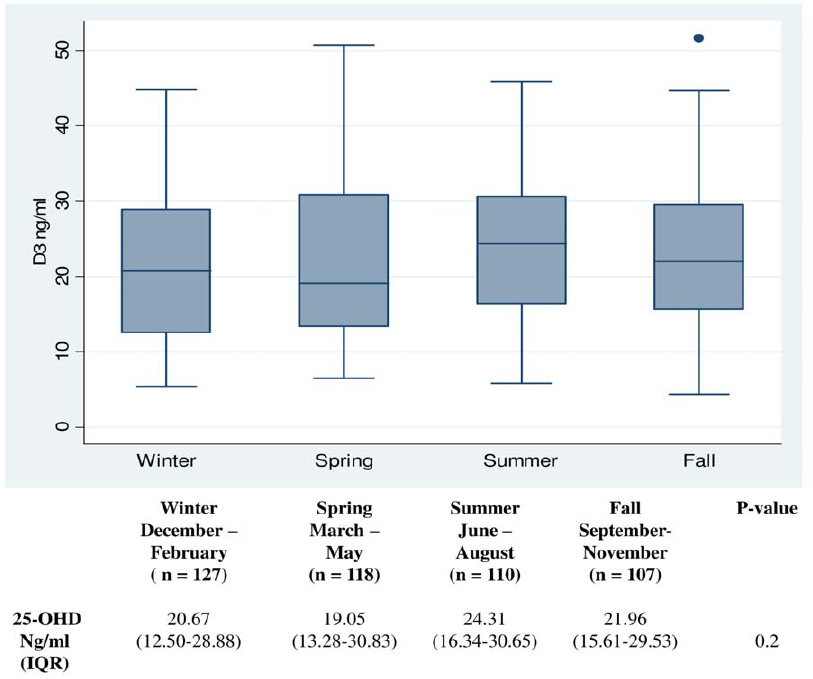
Figure 4. 25-Hydroxyvitamin serum levels plotted as a function of Fev 1 (% pred). Spearman coefficient was determined and the value noted in the lower left of the figure. Table below displays median 25-OHD levels distributed on COPD severity. Significance was tested using Kruskal Wallis equality-of-populations rank test.